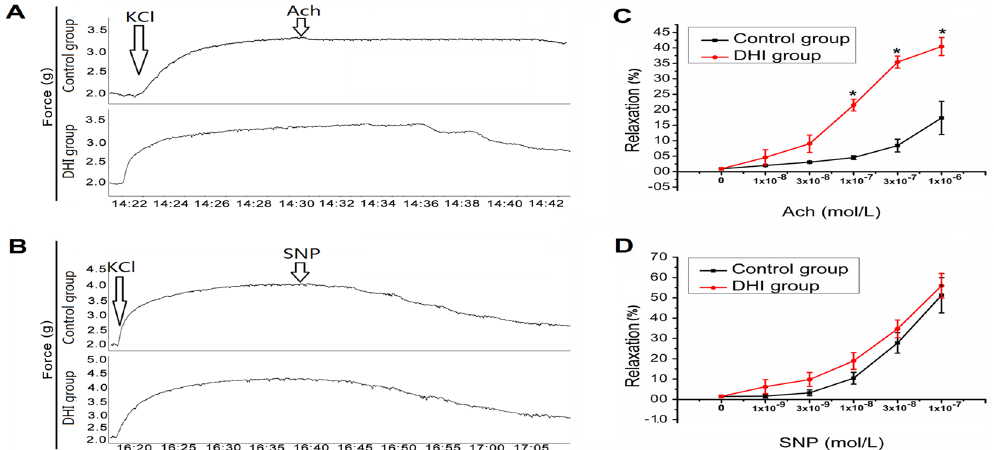
Figure 3. Ach and SNP-mediated vasorelaxation in KCl- precontracted thoracic aortas isolated from DHI- treated SHR. ( A , B ) Raw trace of Ach and SNP-treated aorta and ( C , D ) Quantification of the data in ( A and B ) respectively. The rate of Ach and SNP-induced relaxation was calculated with KCl (60 mM)-induced contraction set to 0. ( C ) DHI treatment significantly (p < 0.01) relaxed aorta in response to Ach stimulation compared with control group in SHR. ( D ) There was no significant difference in response to SNP stimulation between DHI treatment group and control group in SHRs’ aorta. All data are expressed as mean ± SEM, n =